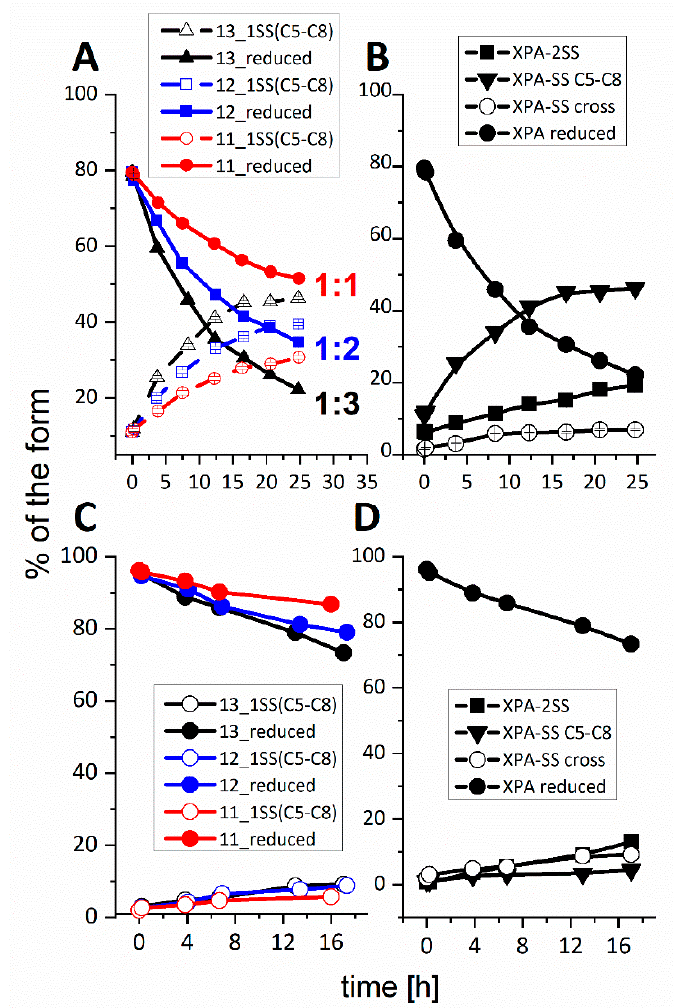
Figure 4. ( A ) The normalized areas of the XPAzf peaks obtained from HPLC after the ZnXPAzf reaction with GSNO and examined with ESI-MS (GSNO concentrations are color coded on the graph). Solid lines trace the reduced XPAzf, which represents the ZnXPAzf complex, dashed lines trace the intermediate XPA-SS C5-C8 . ( B ) Formation of disulfide products for 10 µ M ZnXPAzf and a three-fold excess of GSNO. ( C ) The normalized areas of the XPAzf peaks obtained from HPLC after the CdXPAzf reaction with GSNO and examined with ESI-MS (GSNO concentrations are color coded on the graph). Solid lines trace the reduced XPAzf, which represents the CdXPAzf complex, dashed lines trace the intermediate XPA-SS C5-C8 . ( D ) Formation of disulfide products for 10 µ M CdXPAzf and a three-fold excess of GSNO.